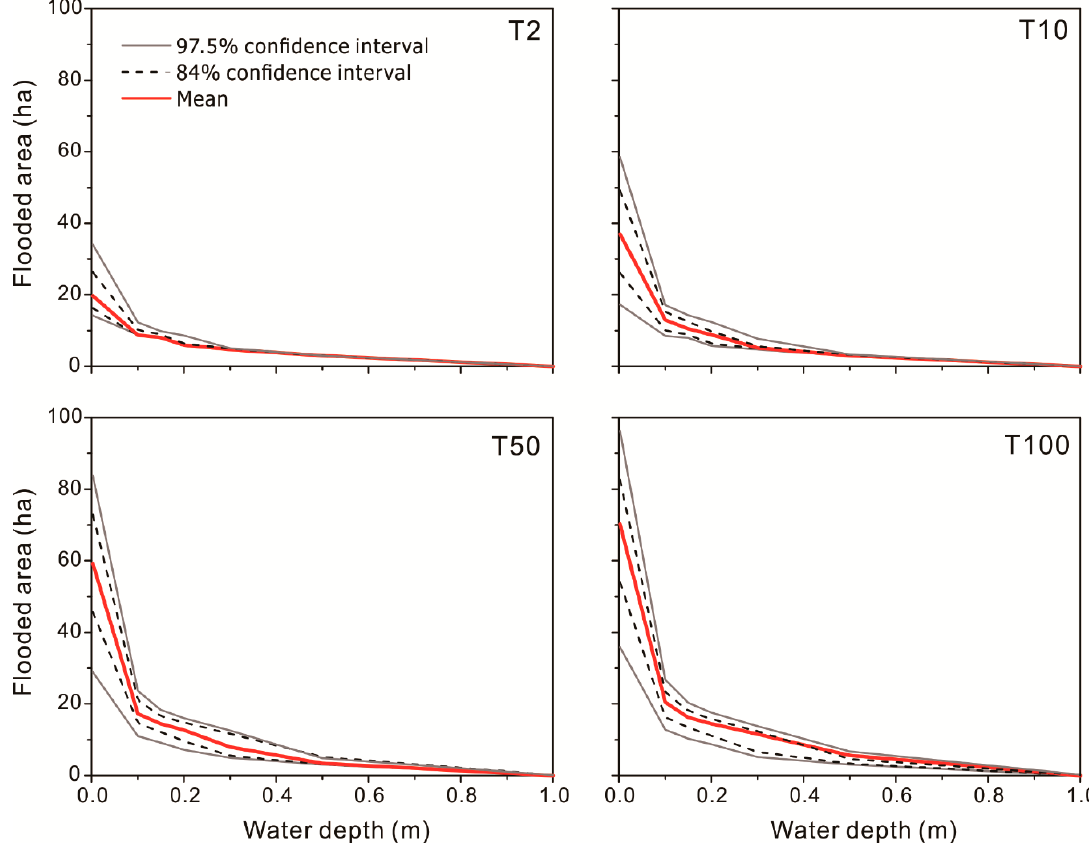
Figure 4. Uncertainty ranges of the staged area-depth functions of T = 2 years, T = 10 years, T = 50 years, and T = 100 years events in year 2010 under the BAU scenario, respectively.